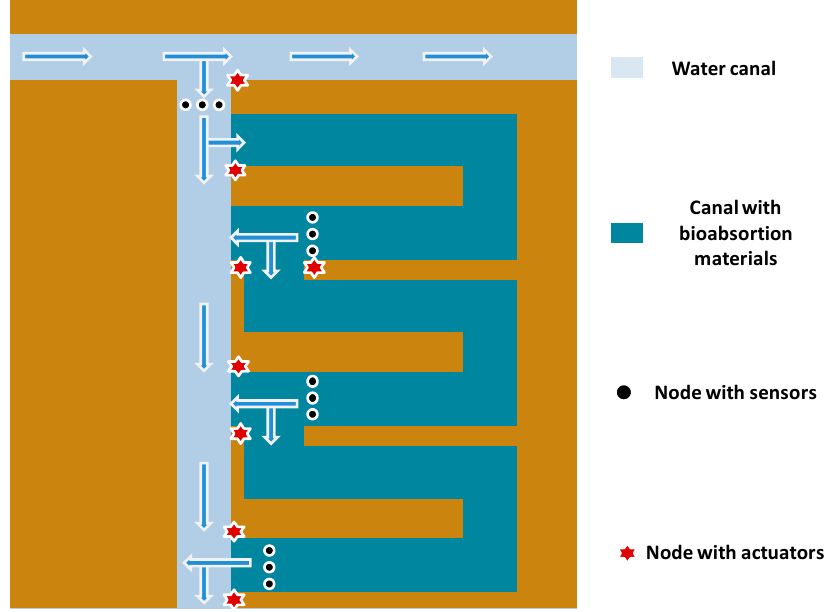
Figure 2. Example of canal zone in detail.